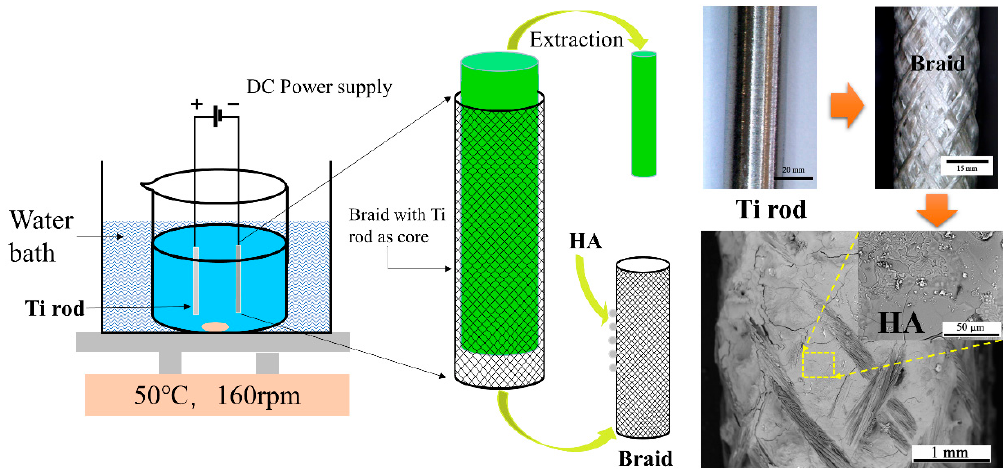
/ PLA-HA composite braid prepared by Figure 1. Images of PVA/PLA-HA composite braid prepared by electrodeposition. Figure 1. Images of PVA